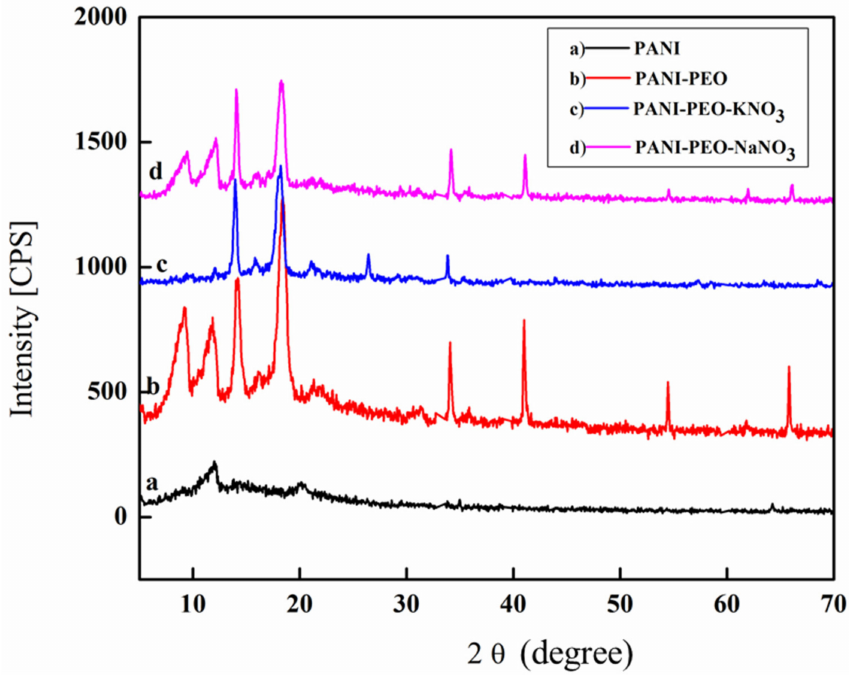
Figure 4. XRD patterns of ( a ) PANI ( b ) PANI-PEO ( c ) PANI-PEO-KNO 3 ( d ) PANI-PEO-NaNO 3 .